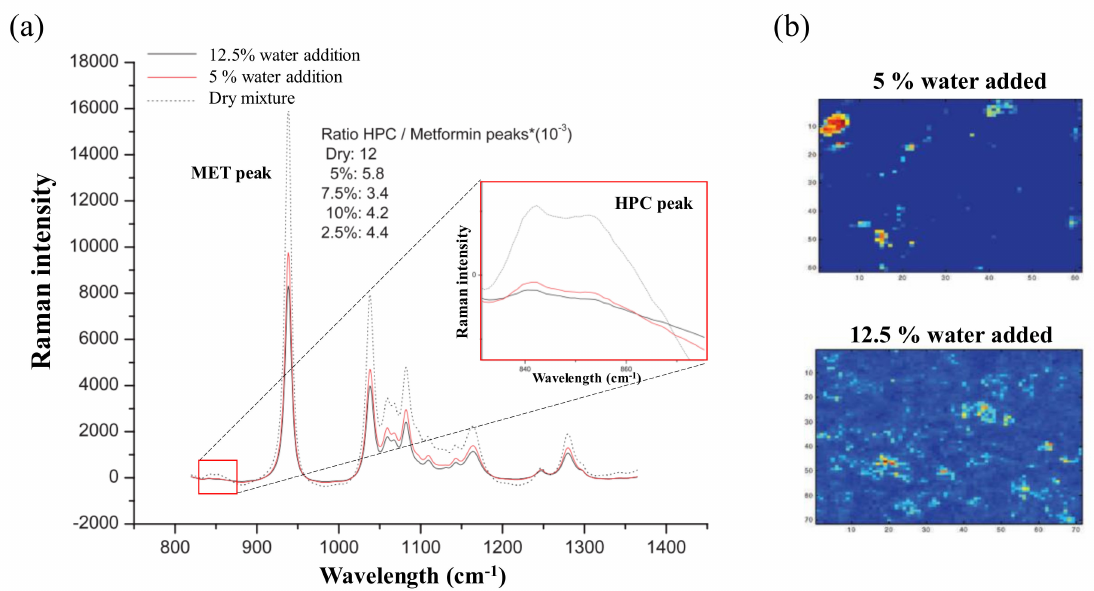
Figure 5. ( a ) Ratio between hydroxypropyl cellulose (HPC) peak (850 cm − 1 ) and metformin peak (938 cm − 1 ) in granules with 5% and 12.5% water and the dry mixture. Strong magnification of the peak at 850 cm − 1 (inset graph) shows the intensity of the HPC band; ( b ) Raman intensity mapping image [38]. The figures were slightly modified, with permission from SAGE